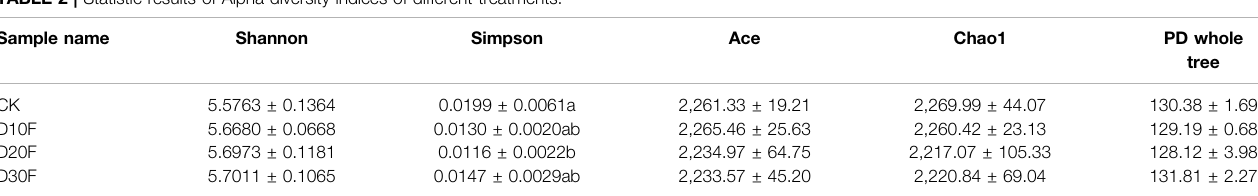
TABLE 2 | Statistic results of Alpha diversity indices of different